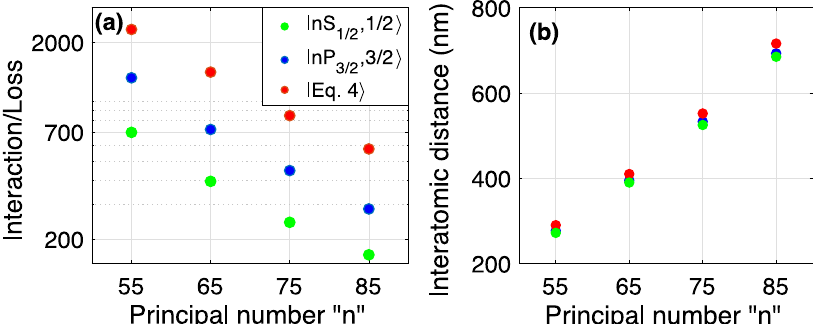
Fig. 3 Scaling of interaction-to-loss ratio. a The scattering interaction of Rydberg electron from the four plaquette atoms over the decay rate of the central Rydberg atom is plotted as a function of the principal number for Rydberg states j nS 1 = 2 ; 1 = 2 i , j nP 3 = 2 ; 3 = 2 i , and for the state presented in Eq. (4). b While operating at smaller n enhances the coherence, it requires smaller inter-atomic distances, raising concerns about single-site addressing,